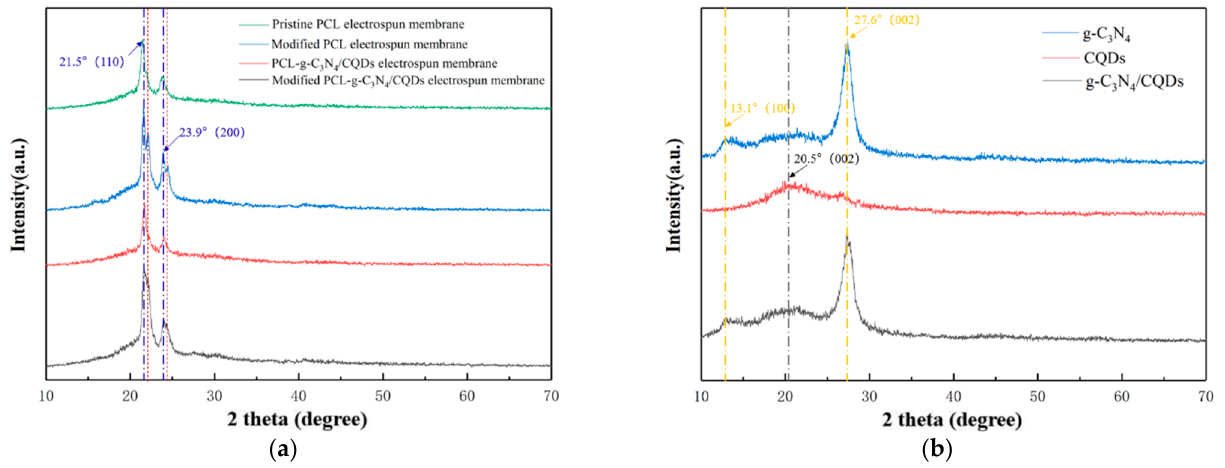
Figure 5. XRD patterns of ( a ) four membranes and ( b ) g-C 3 N 4 , CQDs, g-C 3 N 4 /CQDs.